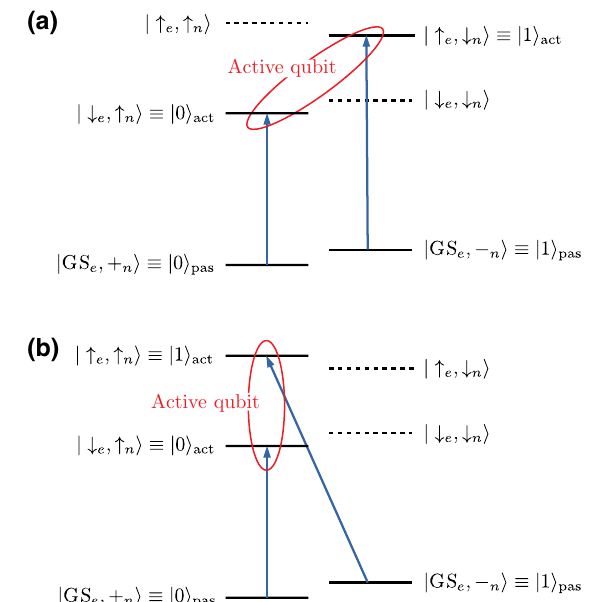
FIG. 3. Two possible choices for the mapping between passive and active qubits: (a) electronuclear qubit and (b) purely elec- tronic qubit. Activation of a qubit is achieved by two π pulses as discussed in the main text. Each pulse leaves one hyperfine state of the passive qubit untouched and takes the other state into one of two target hyperfine states within the excited electronic dou- blet. These two states constitute the active qubit. The two target states have opposite (electronic) magnetic moments, and thus the active qubits can interact over a long